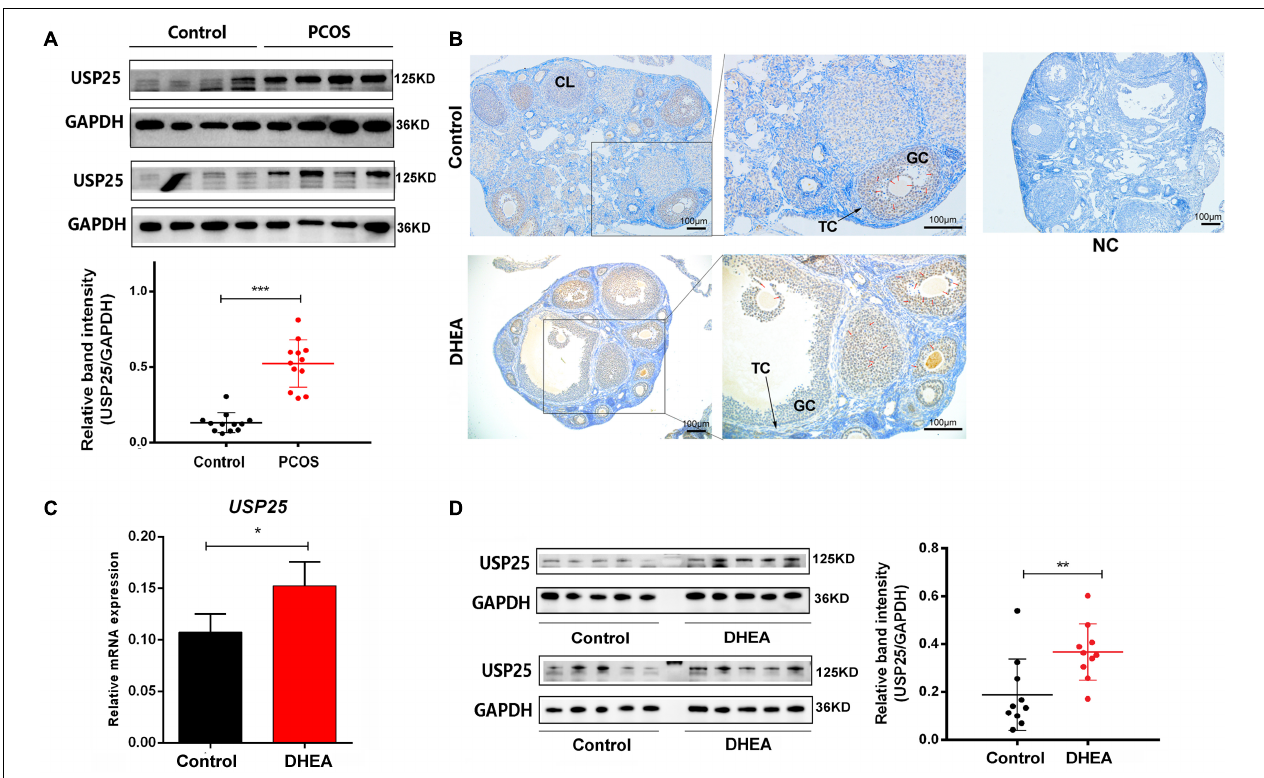
FIGURE 1 | USP25 expression is upregulated in PCOS patients and mice. (A) USP25 protein was detected by Western blotting analysis in human luteinized GCs from patients in the control and PCOS groups ( n = 12 per group). The protein expression level of USP25 was statistically analyzed. (B) Immunochemistry analysis of USP25 in the ovaries from the mice in the control and PCOS groups. Bar = 100 µ m. NC, negative control. Some Positive staining of USP25 are indicated by red arrows. USP25 mRNA (C) and protein levels (D) were detected in mouse ovaries from the control and PCOS groups by quantitative real-time PCR and Western blots. The quantification of protein levels is presented on the right. In panels (A–D) , data are expressed as the mean ± SD. The P -values were calculated by an unpaired two-tailed Student’s t -test compared with controls. * P < 0.05, ** P < 0.01, *** P <